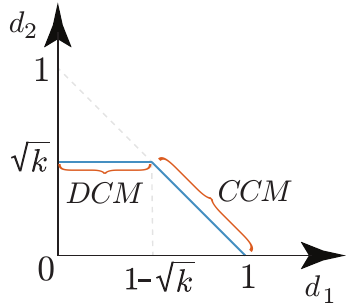
Figure 5. Operation zones of high-order